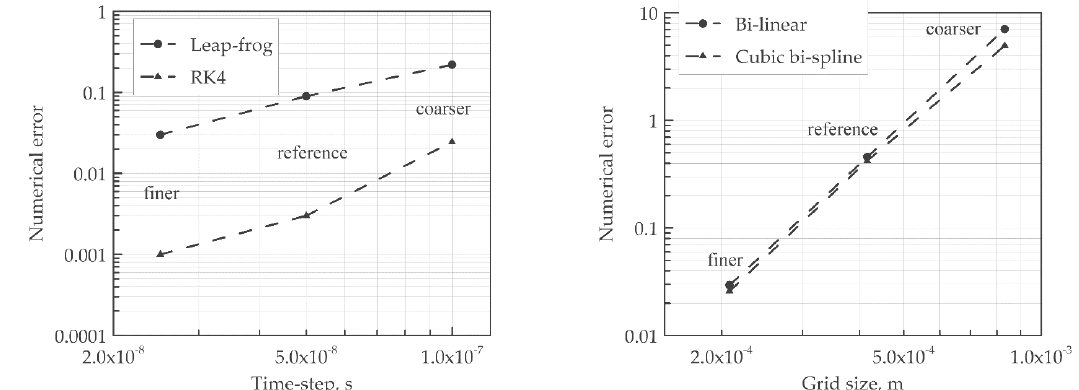
Figure 8. Comparison of the numerical errors.